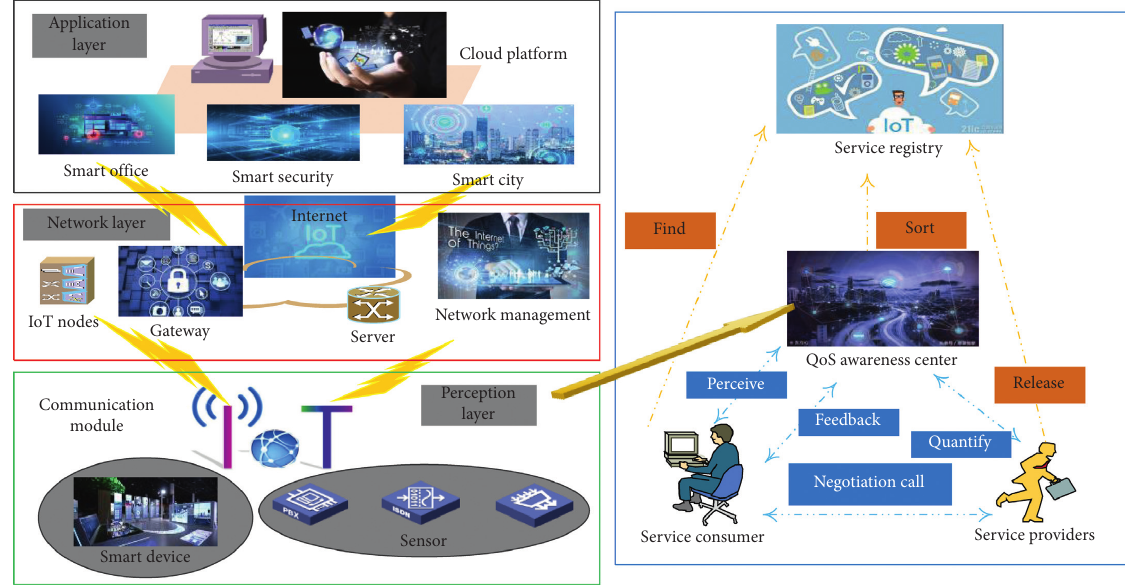
Figure 2: Q-WSFM model in IoT